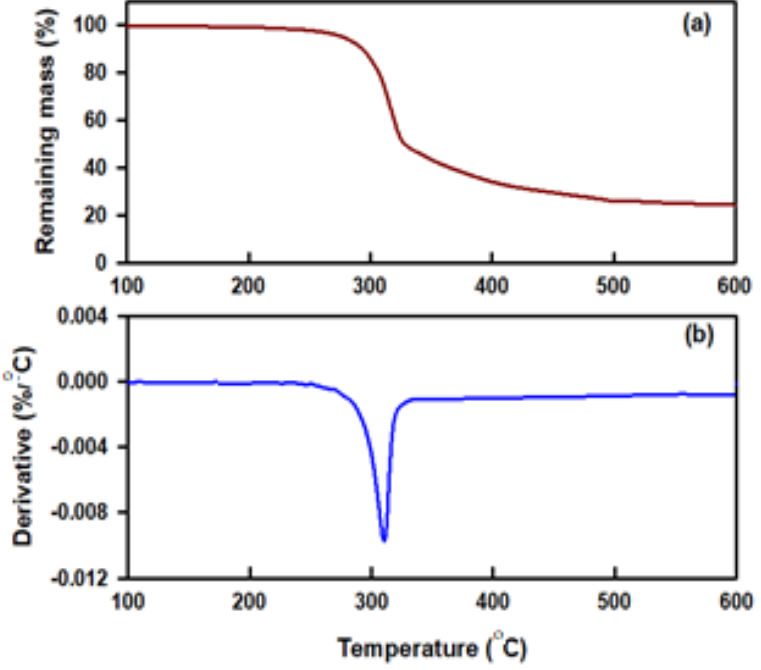
Figure 5. TG ( a ) and DTG ( b ) curves of the compound I 6 .